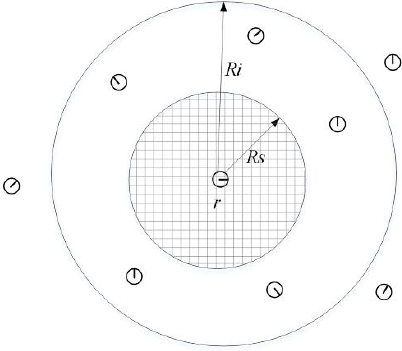
Figure 3. Covered radius Rs and sense radius Ri